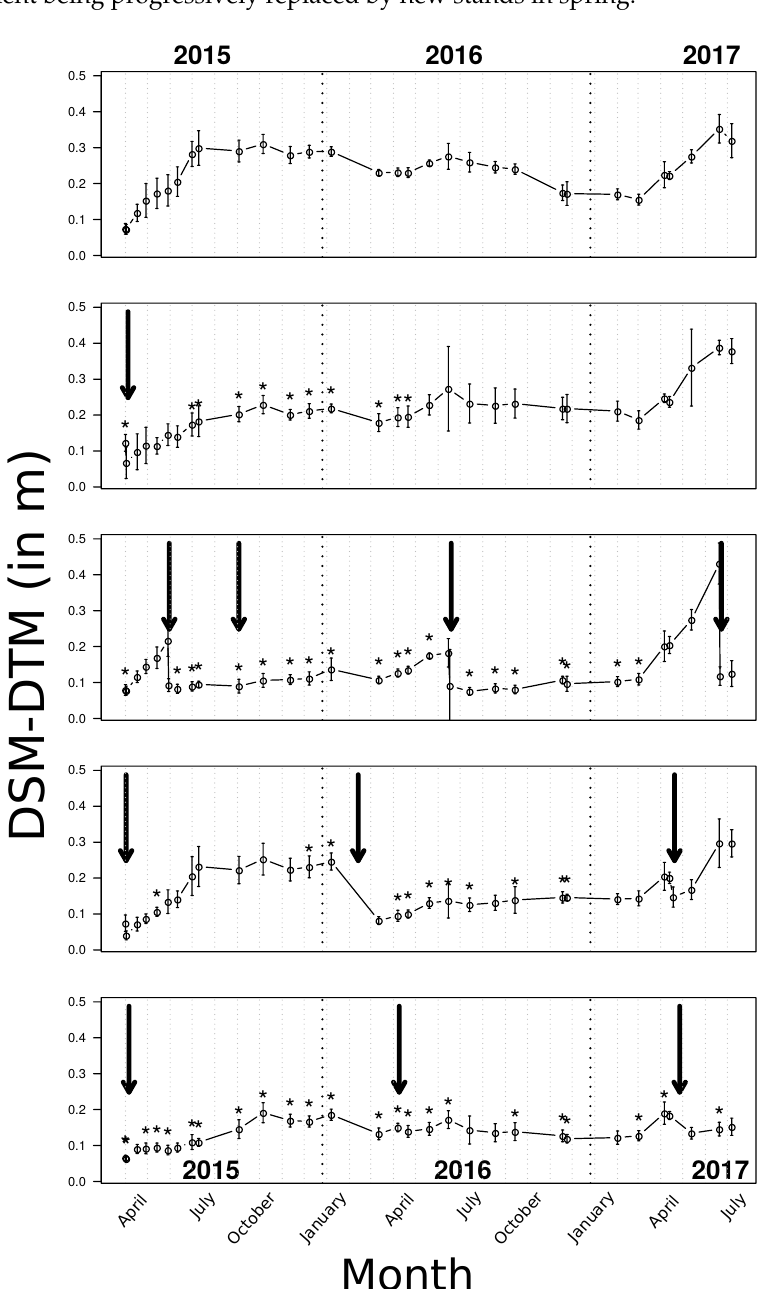
Figure 5. Evolution of the mean difference between the DSM and the DTM across different treatments presented from top to bottom: control, dredged, mowed, burned, and chemically weeded. The dots correspond to the value averaged over the four replicates, and the vertical lines, to the standard deviation. Black arrows indicate the timing of the practice. The star symbol * indicated that treatment was significantly different from control at p < 0.05 (based on Tukey’s